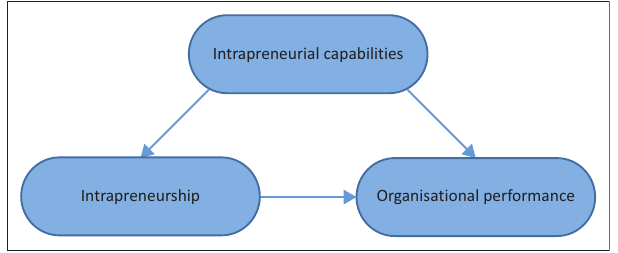
FIG URE 1: Conceptual framework of the TABLE 1: Descriptive analysis of intrapreneurial capabilities, intrapreneurship and organisational performance. Variables Mean Standard deviation